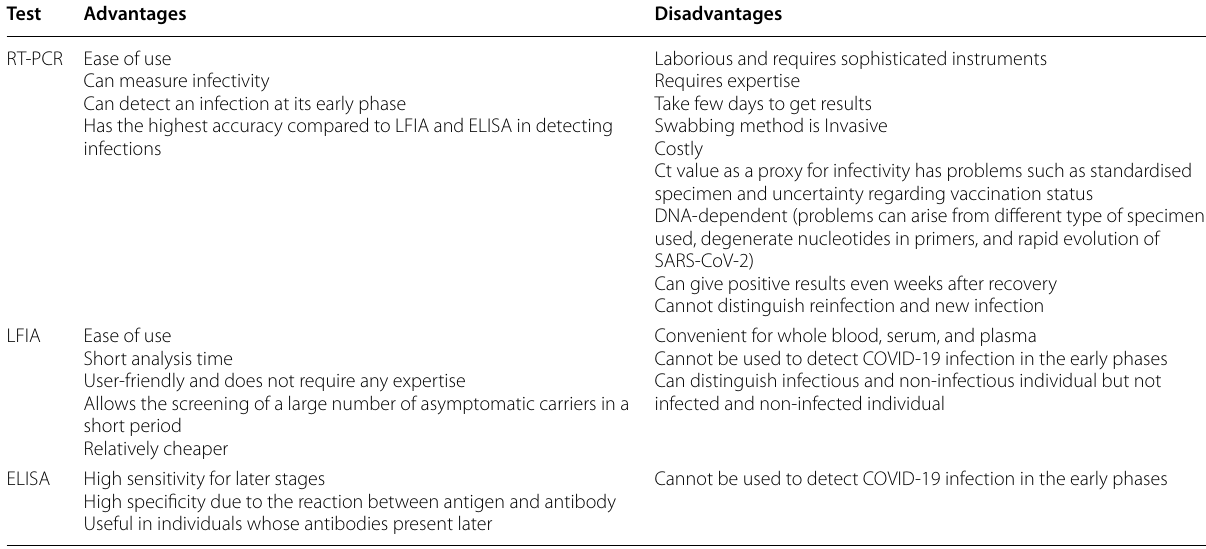
Table 3 Advantages and disadvantages of RT-PCR, LFIA, and